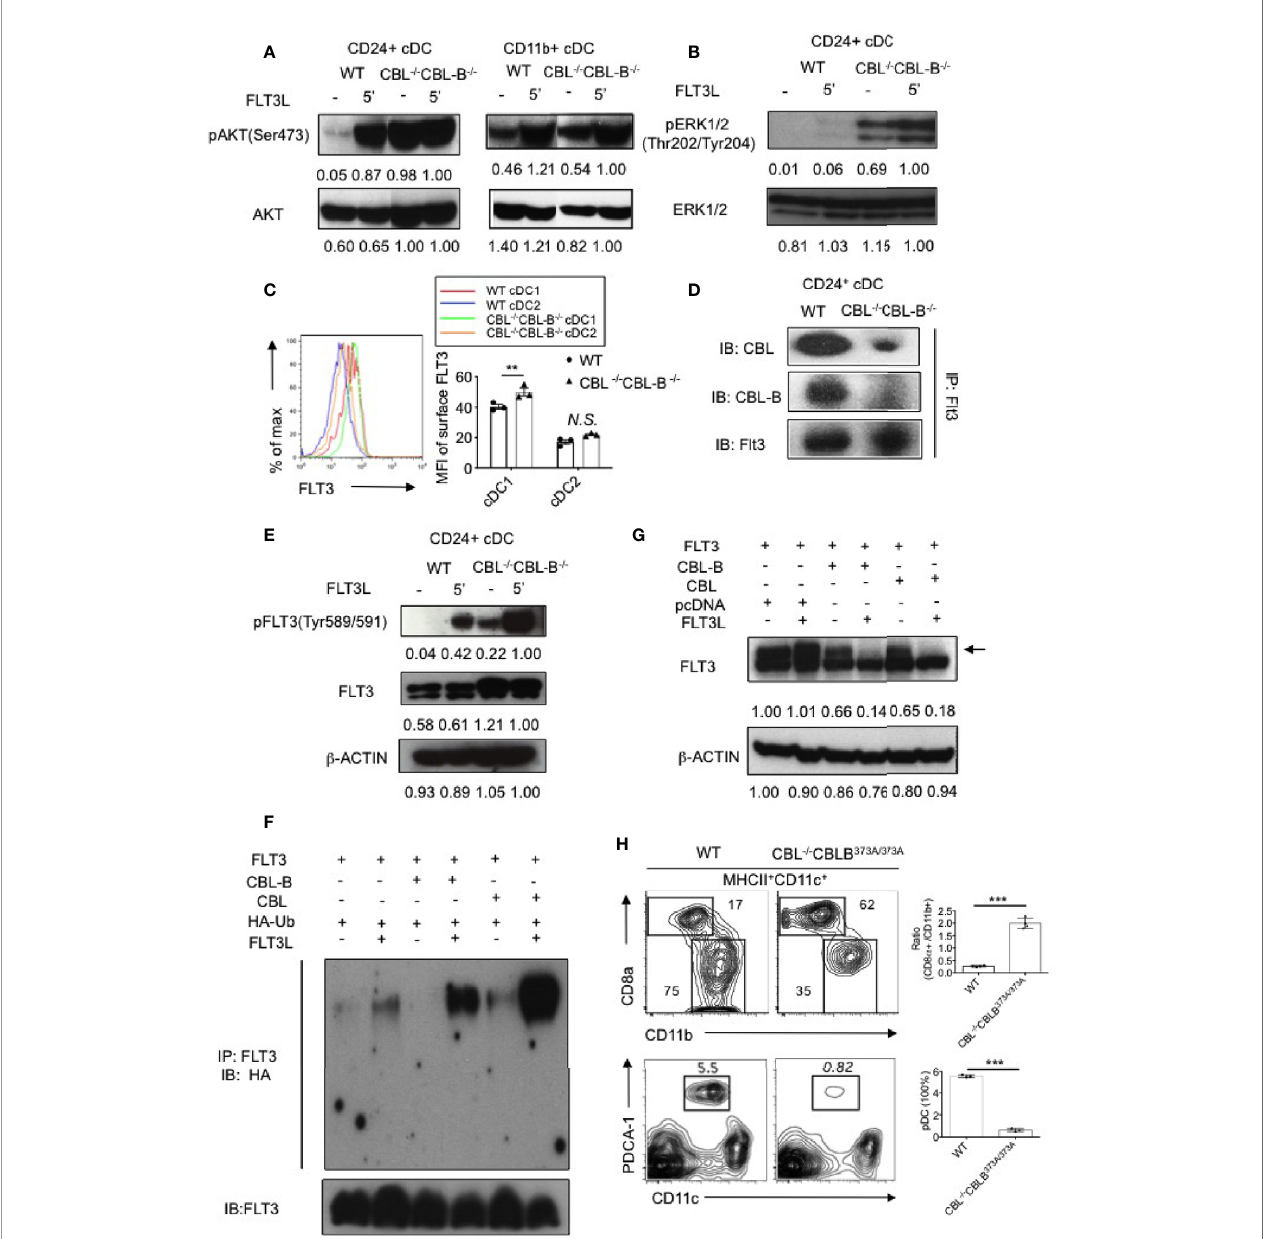
FIGURE 3 | Analyses of FLT3 ubiquitination and signaling by CBLs. (A) Western blot analysis of AKT activation in WT and CBL -/- CBL-B -/- cDC1s and cDC2s (n = 2). (B) Western blot analysis of ERK1/2 activation in WT and CBL -/- CBL-B -/- cDC1s (n = 2). (C) Cell surface expression of FLT3 in WT and CBL -/- CBL-B -/- cDC1s and cDC2s (n = 3). (D) Association of FLT3 with CBL and CBL-B in BM derived CD11c + CD24 hi cDC1s (n = 2). (E) Western blot analysis of FLT3 activation. pFLT3 (Tyr589/591): active form of FLT3 (n = 2). (F) Western blot analysis of FLT3 ubiquitination (n = 2). (G) Western blot analysis of phosphorylated FLT3 (pFLT3) (n = 2). (H) Dependence of CD8 a + cDC1 and pDC homeostasis on CBL ubiquitin ligase activity. Shown are contour maps (left) and statistics (right) of splenic cDC1s and cDC2s (top) and pDC (bottom) in WT and CBL -/- CBL-B C373A/C373A mice (n = 3-4). Data are mean ± SEM. of at least two independent experiments (A , B , D – H) , and one experiment for (C) N.S., not signi fi cant; **p < 0.01; ***p <